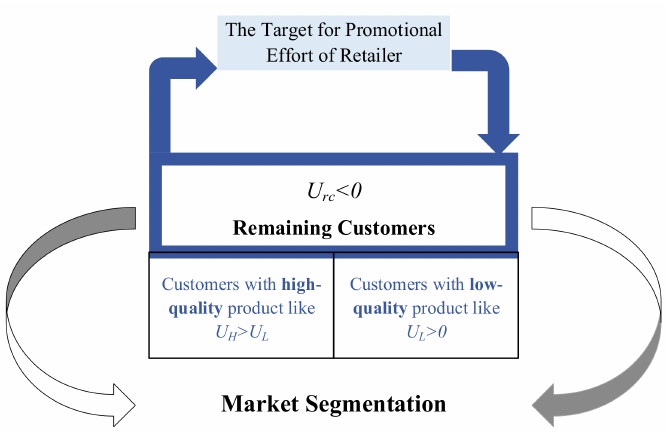
Figure 2. Segmentation of the market into customers desiring high-quality products, customers desiring low-quality products, and the remaining